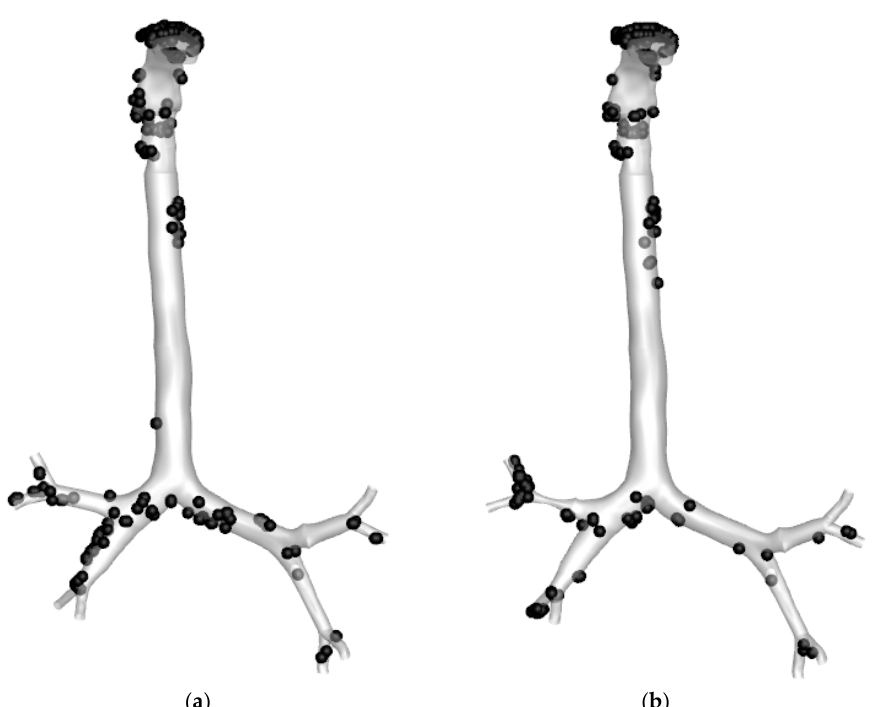
Figure 16. Particle deposition of 2.5 µm particles at a flow rate of 60 L/min; ( a ) Healthy lung model, ( b ) Stenosis lung airways.